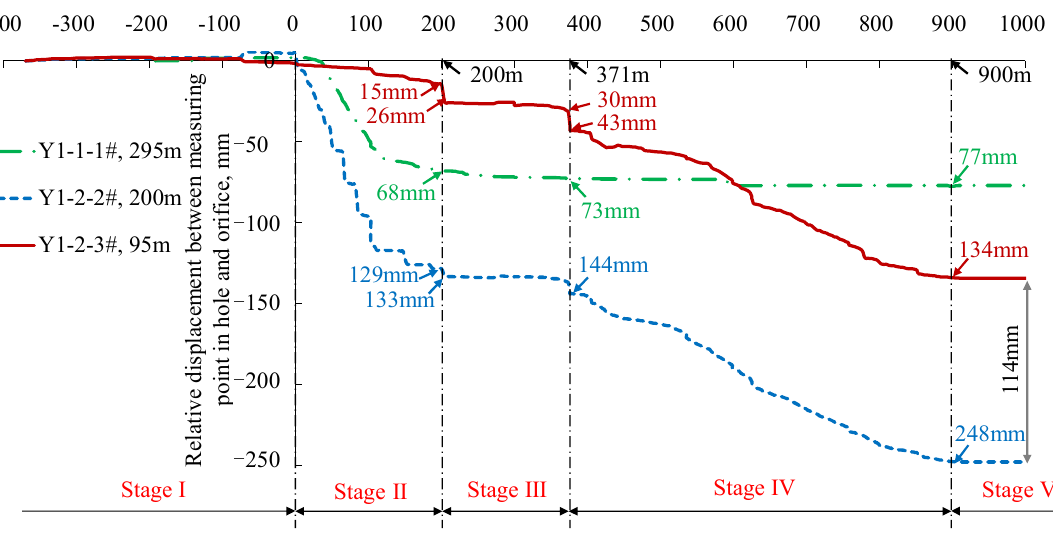
Figure 13. Curves of the rock movement measuring points in the borehole.